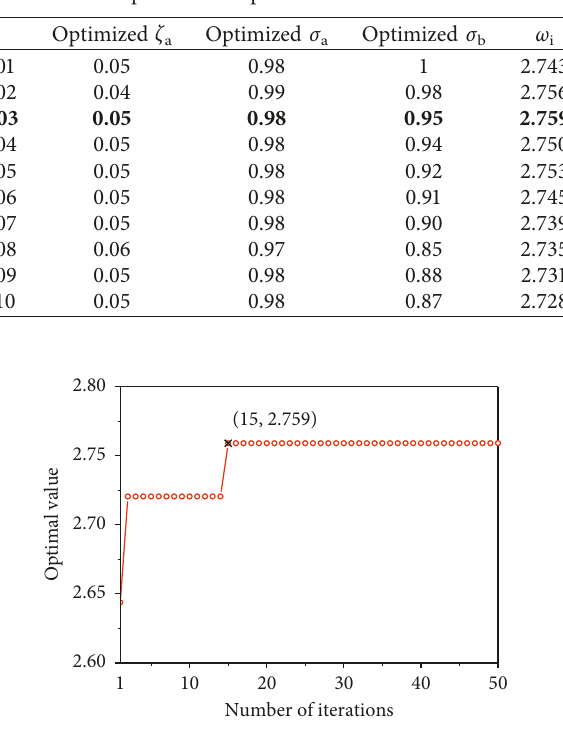
Figure 4: The optimization convergence result of the IDVA as ε b �